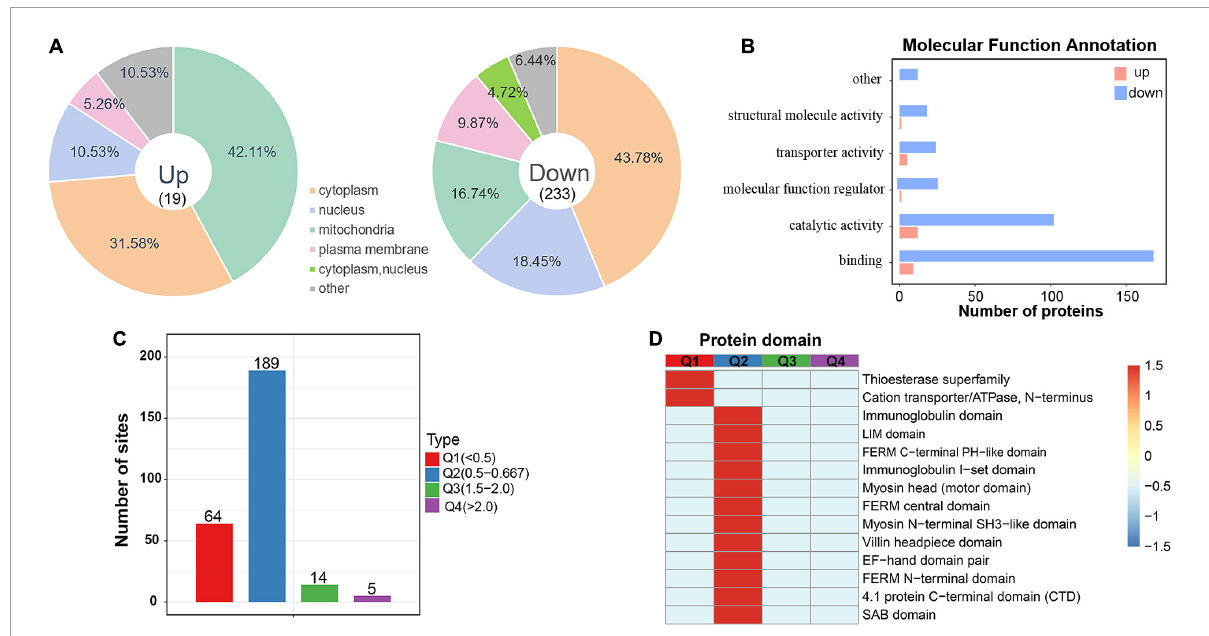
FIGURE4 Subcellular location and protein domain analysis of significantly up and downregulated acetylated proteins. (A) Subcellular location analysis for significantly up and downregulated acetylated proteins, respectively. (B) Molecular function annotation for significantly up and downregulated acetylated proteins. (C) Degree of modification of differentially acetylated proteins. (D) Protein domain analysis for the Q1–Q4 quantiles in panel (C)